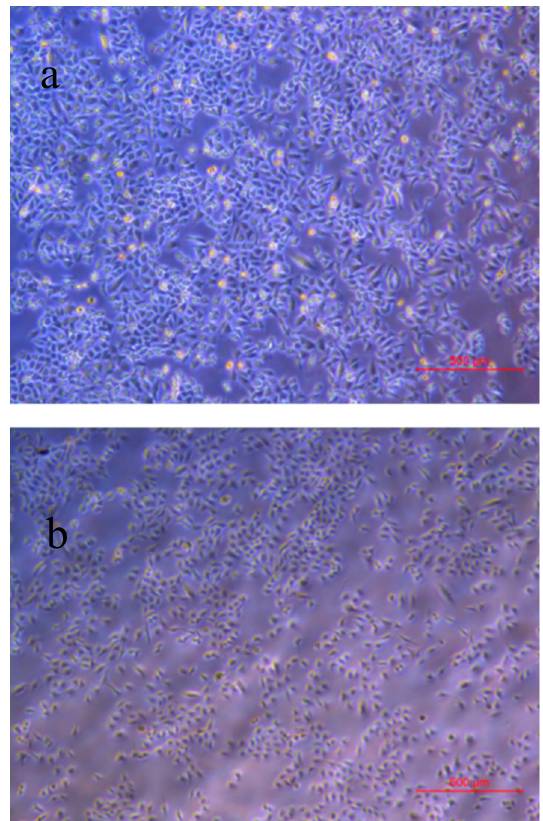
Figure 1. Images of the A549 cells in control ( a ) and catechin (600 μ moL) treatment ( b ) groups after 24 h of incubation.